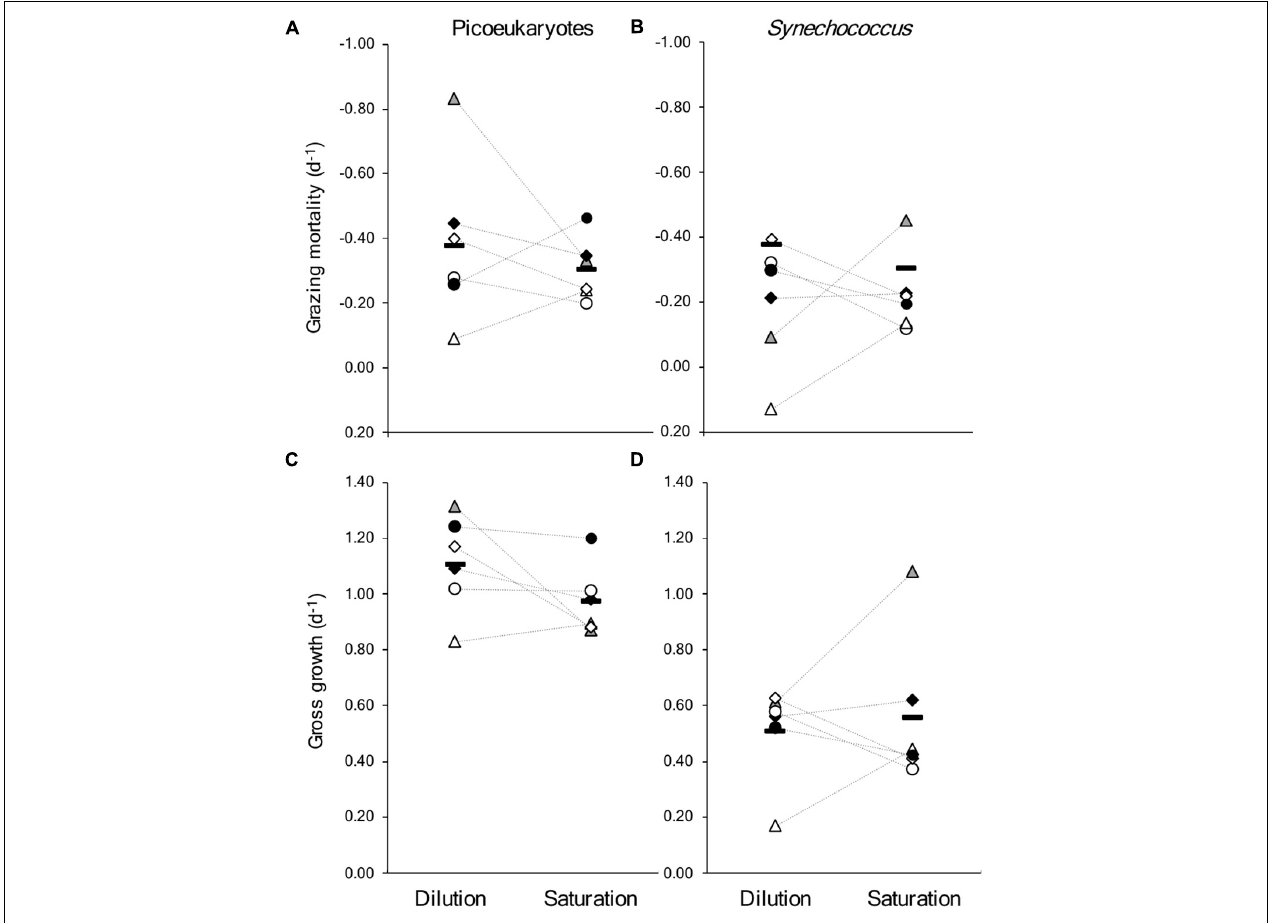
FIGURE 4 | Comparison of results from the six saturation and dilution experiments run in parallel in coastal waters of the Gulf of Maine in the summers of 2019 and 2021. Showing rates of mortality due to grazing for (A) picoeukaryotes, and (B) Synechococcus ; and gross growth rates for (C) picoeukaryote, and (D) Synechococcus . Paired symbols represent parallel experiments; gray triangle: day 197 (2019), black diamond: 204 (2019), open circle: 174 (2021), open triangle: 182 (2021), open diamond: 196 (2022), filled circle: 207 (2022); the horizontal bars are the mean of the six experiments, the dotted lines connect experiments run on the same day. The values and associated levels of uncertainty are included in Table 2 and Supplementary Tables 1, 2 . The dilution approach generated a positive slope for the relationship between apparent growth and level of dilution for Synechococcus on day 182 ( Supplementary Table 1